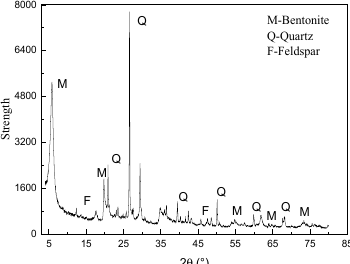
Figure 1. XRD diffraction diagram of bentonite.